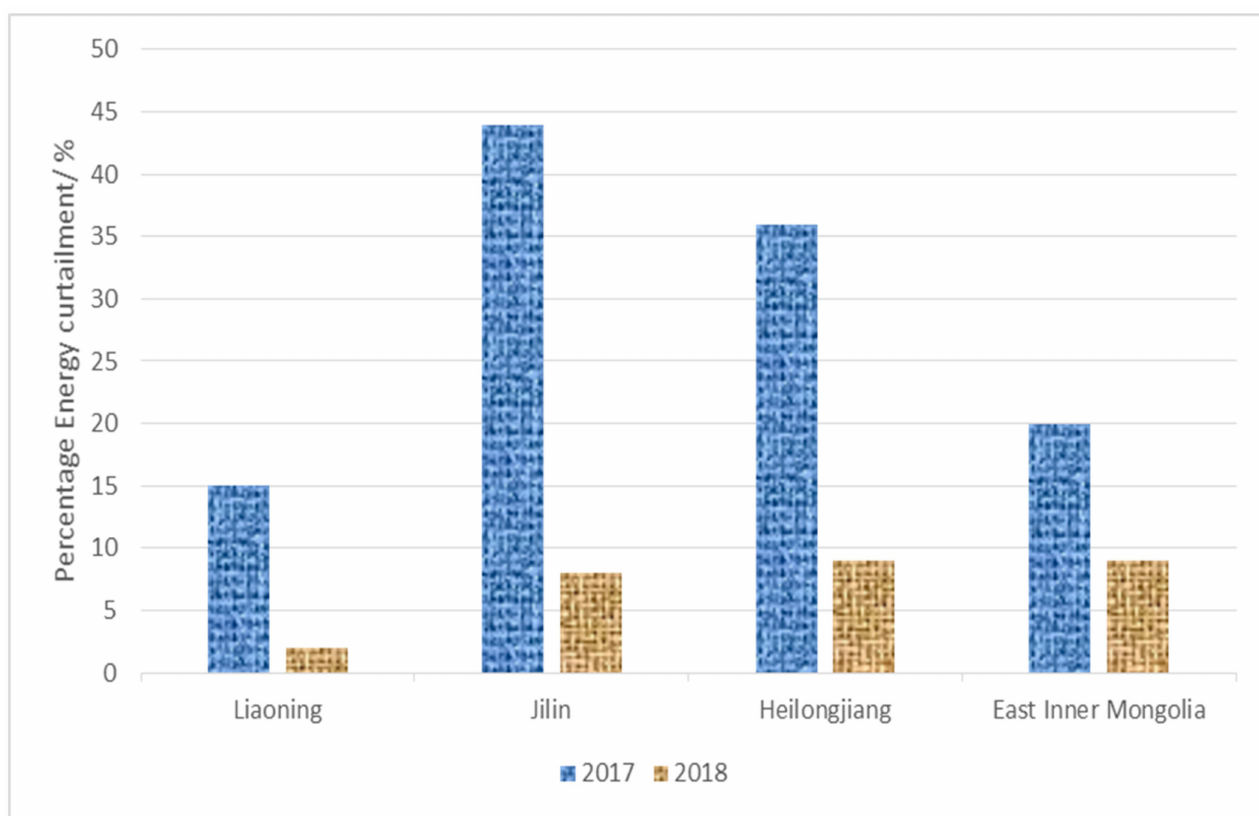
Figure 17. Percentage curtailment of wind power in northeastern provinces of China within the first quarter of 2017 and 2018